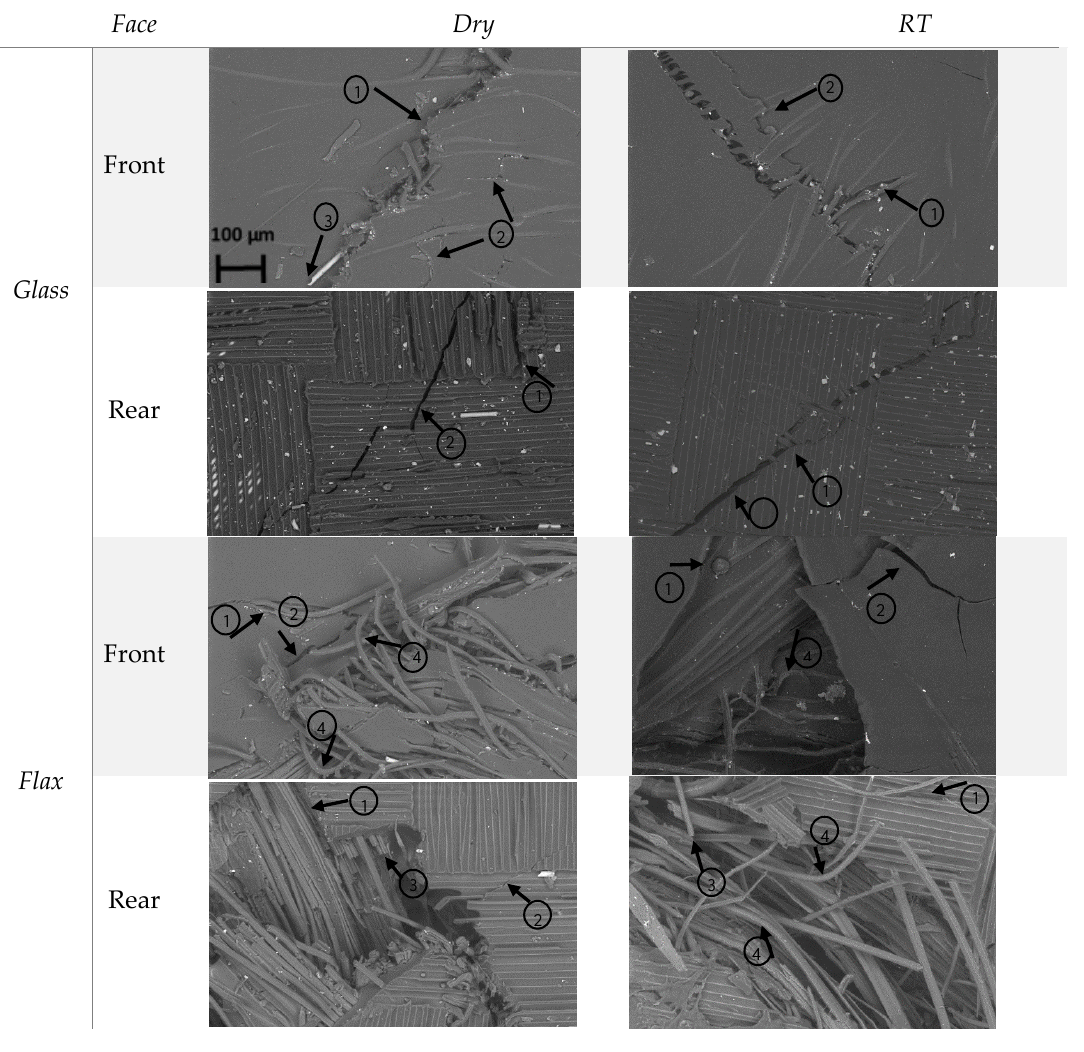
Figure 6. X-ray pictures of dry and RT immersed glass fibre, flax fibre and hybrid composites showing the damage mechanisms: (1) show delamination, (2) matrix cracking.